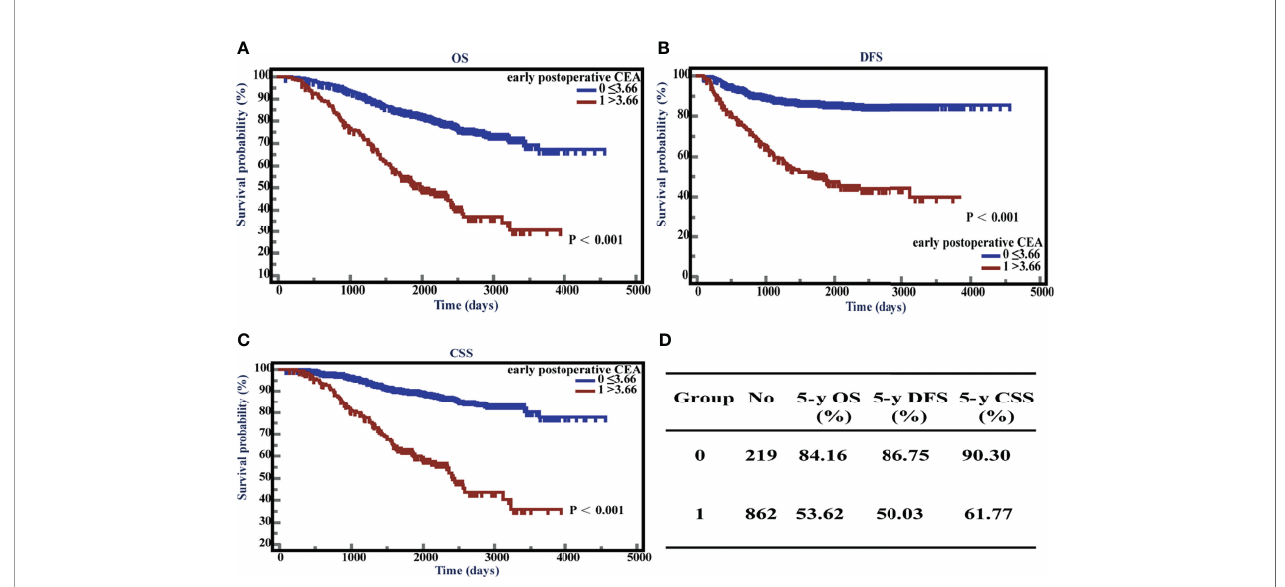
and 50.39%, respectively, and of patients with CEA absolute value >-0.98 were 81.79%, 85.10%, and 88.98%, respectively. K- M curves illustrated that patients with CEA ratio ≤ 0.55 or CEA absolute value ≤ -0.98 had a worse OS, DFS, and CSS than CEA ratio >0.55 or CEA absolute value >-0.98 (p < 0.001)